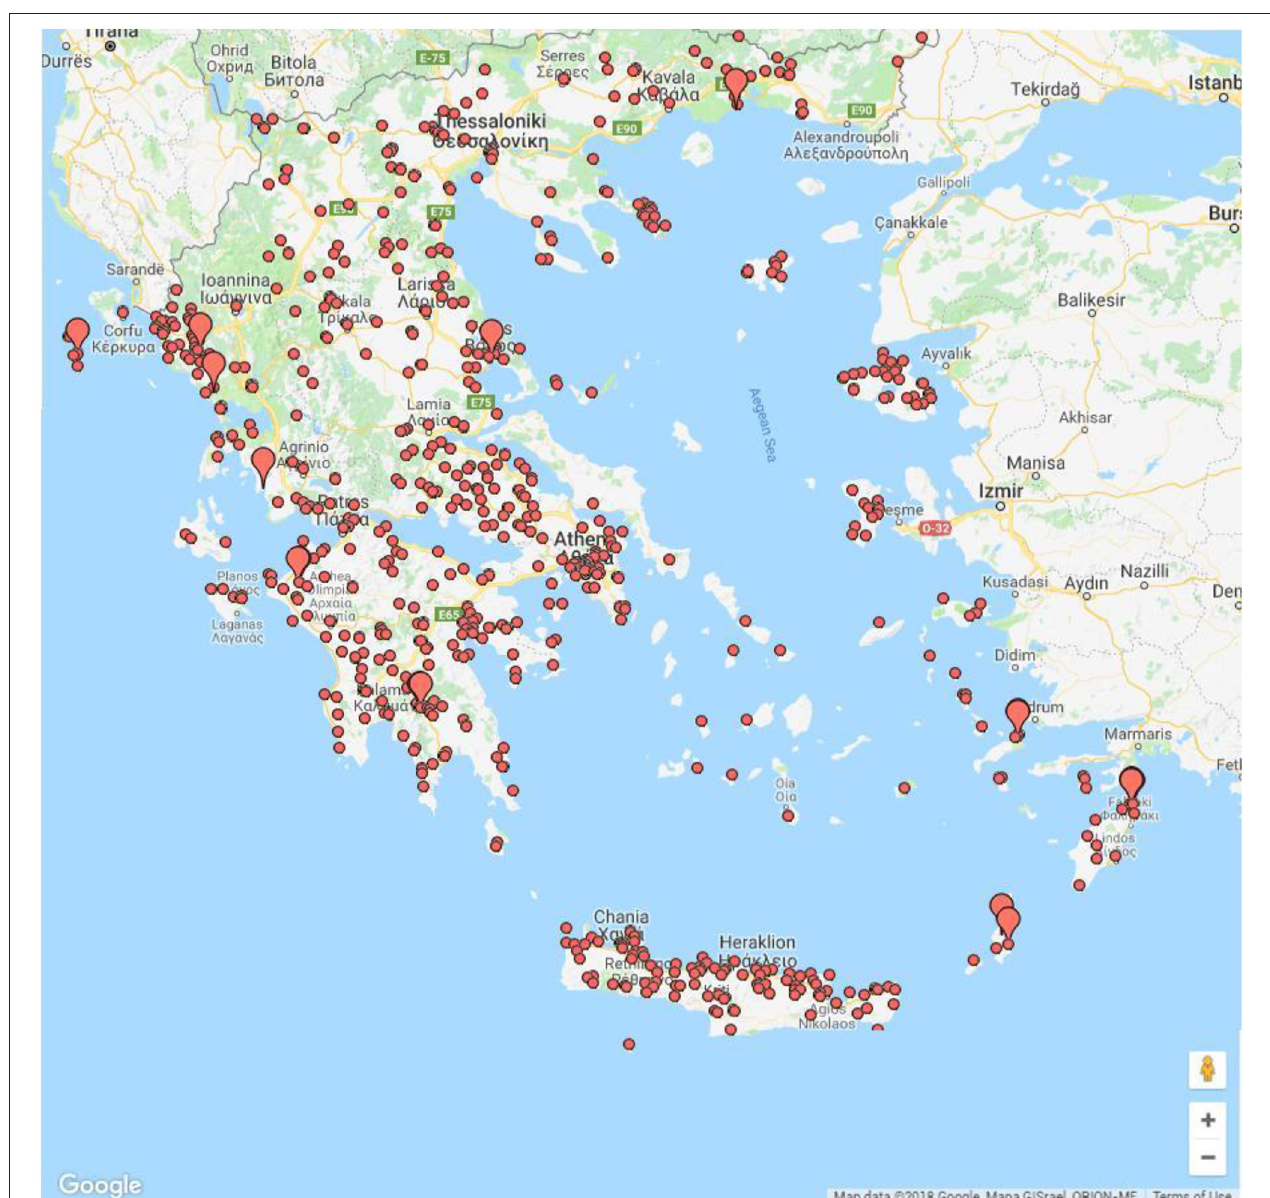
FIGURE 3 | Map of archaeological sites in Greece “Monuments In Greece”. (Odysseus.Culture.Gr. http://odysseus.culture.gr/a/map/emap.jsp,